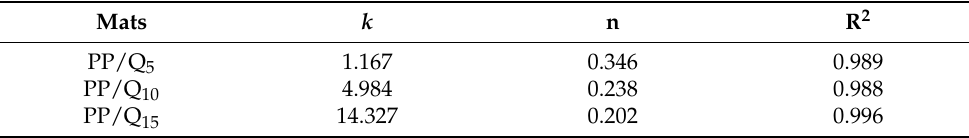
Table 1. Kinetic interpretation by using Korsmeyer–Peppas for QUE release from PP mats. Mats k n R 2 PP/Q